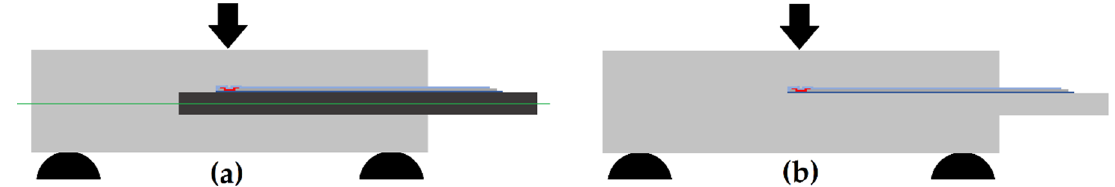
Figure 9. ( a ) A schematic cross view of the sensor with the neutral fiber and the substrate; ( b ) a schematic cross view of the sensor, only showing the foreign matter in the casting good.